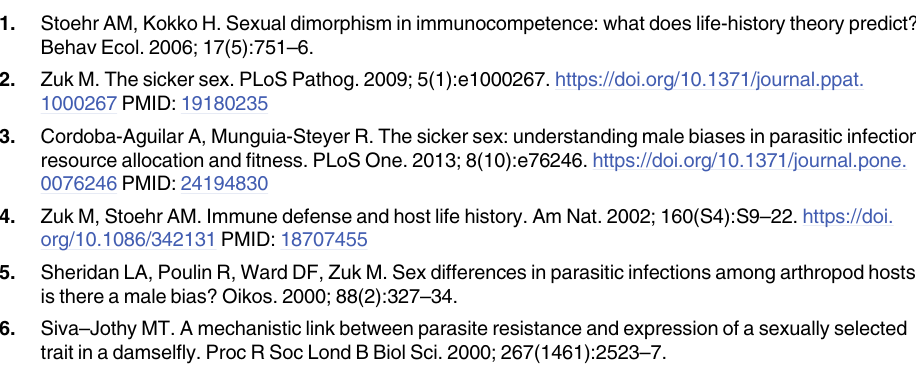
S2 Table. Linear mixed effects models (LMMs) for differences in body weight, total length, abdomen area and thorax area between non-parasitized immature and mature female damselflies. Results from linear mixed effects models (LMMs) for differences in body weight, total length, abdomen area and thorax area between non-parasitized immature and mature female damselflies. S3 Table. Mann-Whitney U-test for differences in body weight, total length, abdomen area and thorax area between non-parasitized Agriocnemis femina and Agriocnemis pygmaea . Results of Mann-Whitney U-test for differences in body weight, total length, abdomen area and thorax area between Agriocnemis femina and Agriocnemis pygmaea